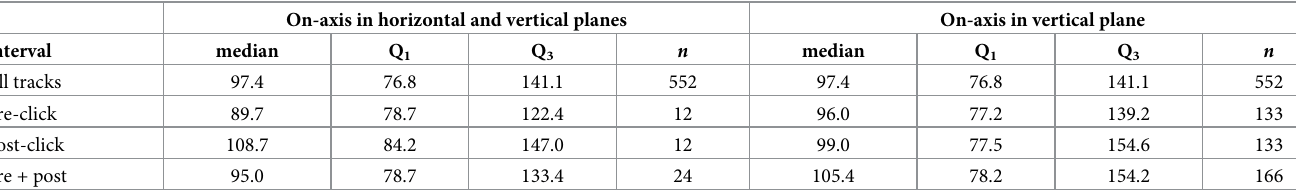
Median ICI values were calculated for all clicks from same the click sequence, or track, as the selected on-axis clicks (all tracks), before the on-axis click (pre-click), after the on-axis click (post-click), and pooled pre- and post- intervals (pre + post). 25% and 75% quantiles (Q 1 and Q 3 , respectively) and sample sizes of clicks considered ( n ) are included. All reported values are in